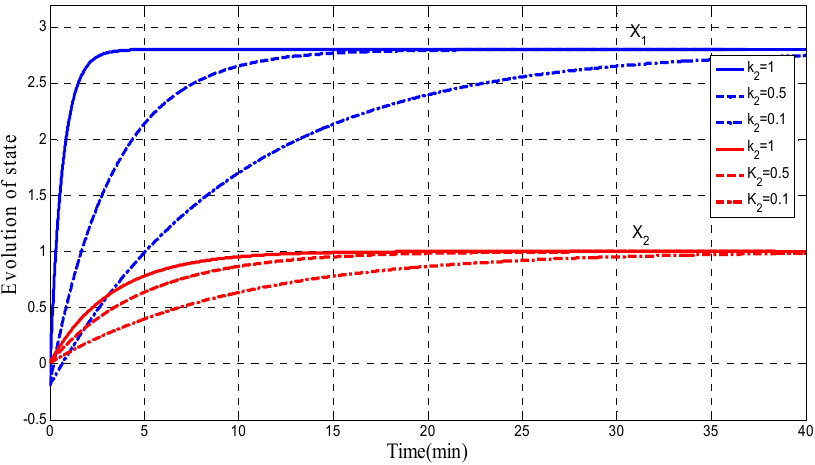
Figure 3. Tracking during startup.